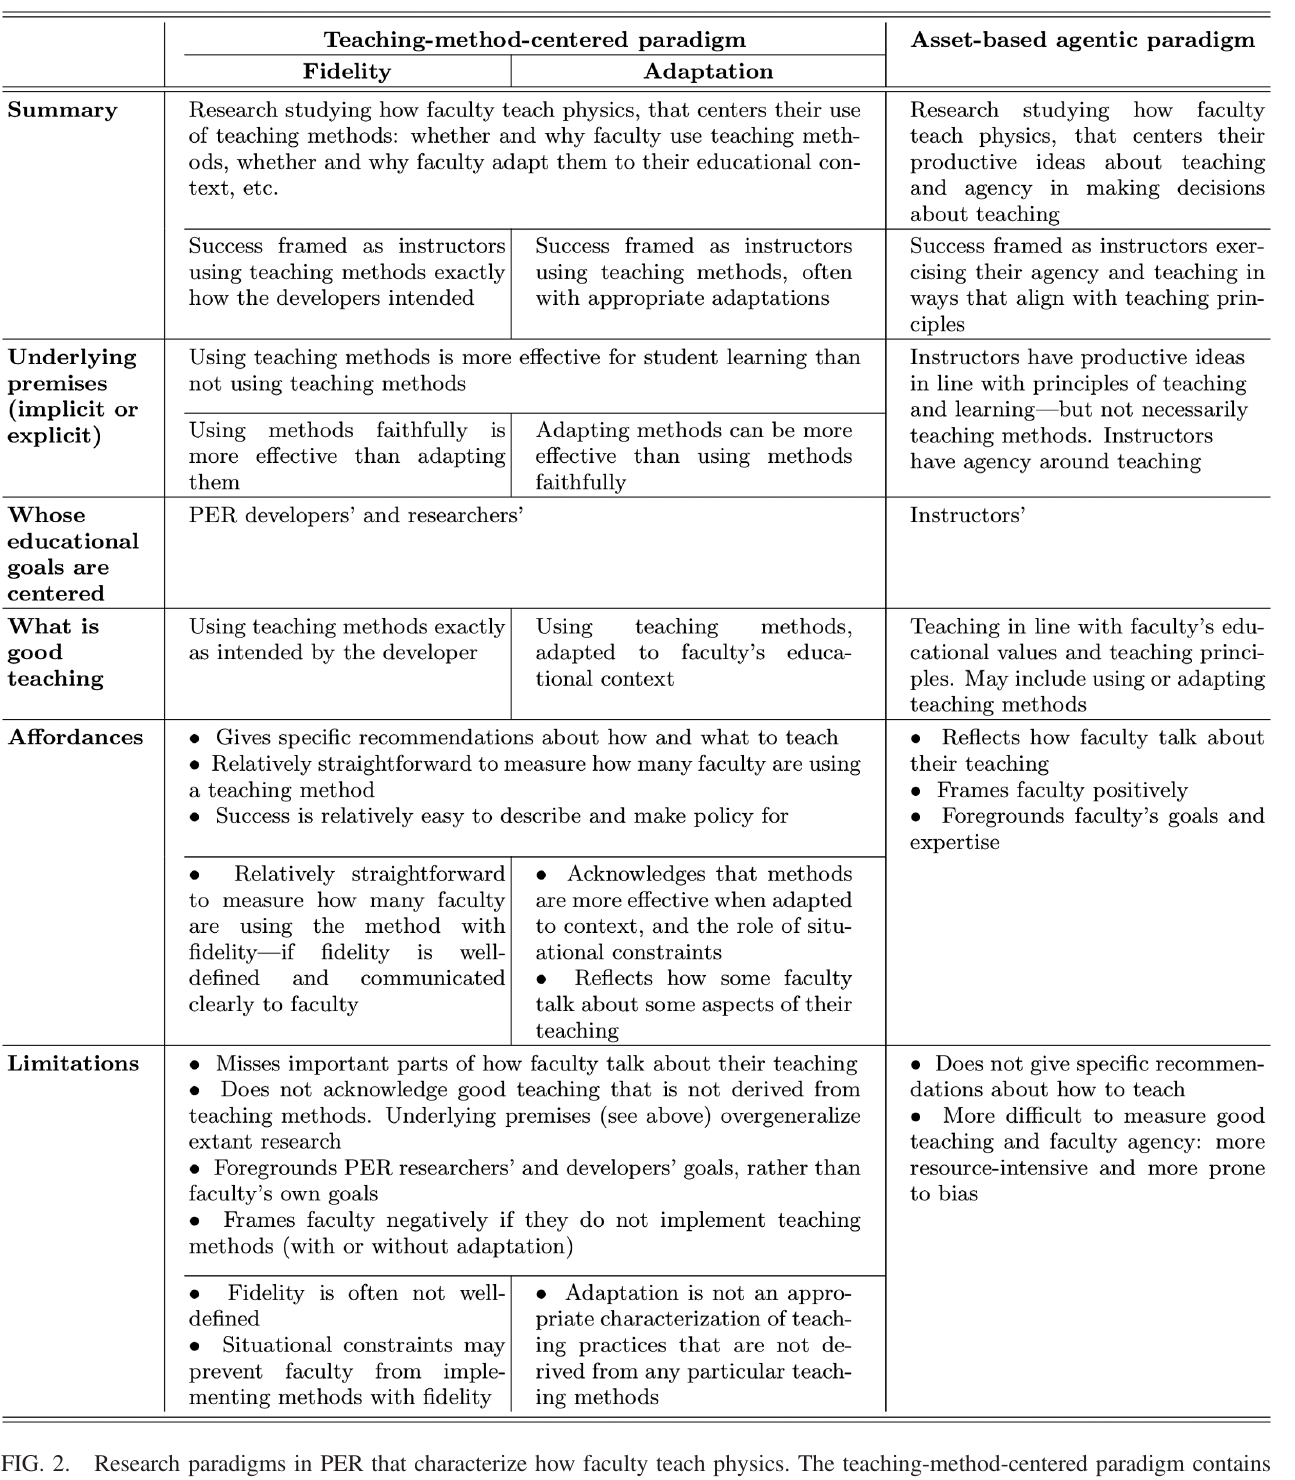
FIG. 2. Research paradigms in PER that characterize how faculty teach physics. The teaching-method-centered paradigm contains three research strands (see main text); the table does not include the familiarity strand because that strand only describes faculty knowledge, not faculty teaching